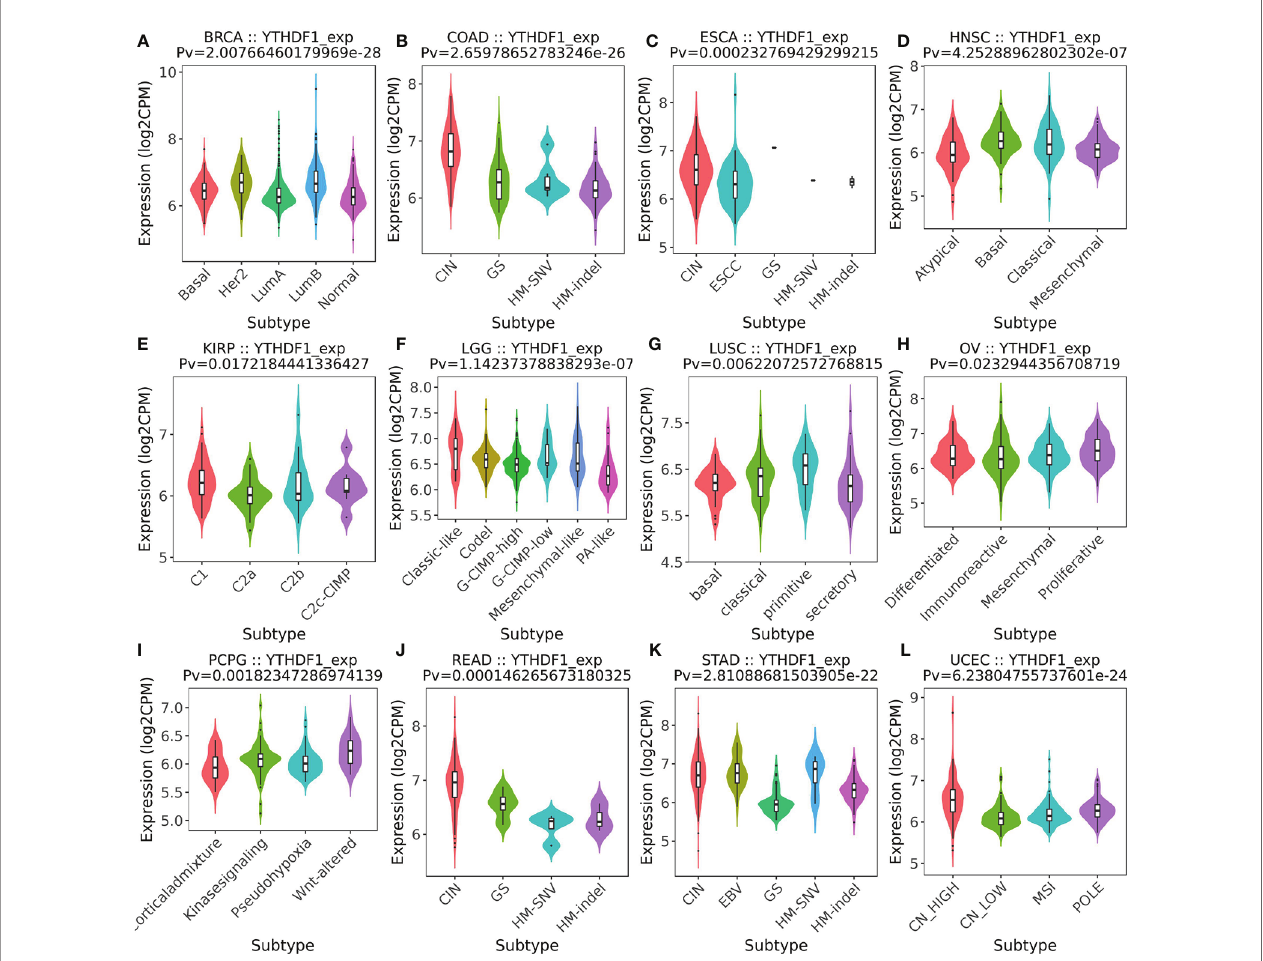
FIGURE 4 | The relationship between YTHDF1 expression and pan-cancer molecular subtypes. (A) in BRCA, (B) in COAD, (C) in ESCA, (D) in HNSC, (E) in KIRP, (F) in LGG, (G) in LUSC, (H) in OV, (I) in PCPG, (J) in READ, (K) in STAD, (L) in